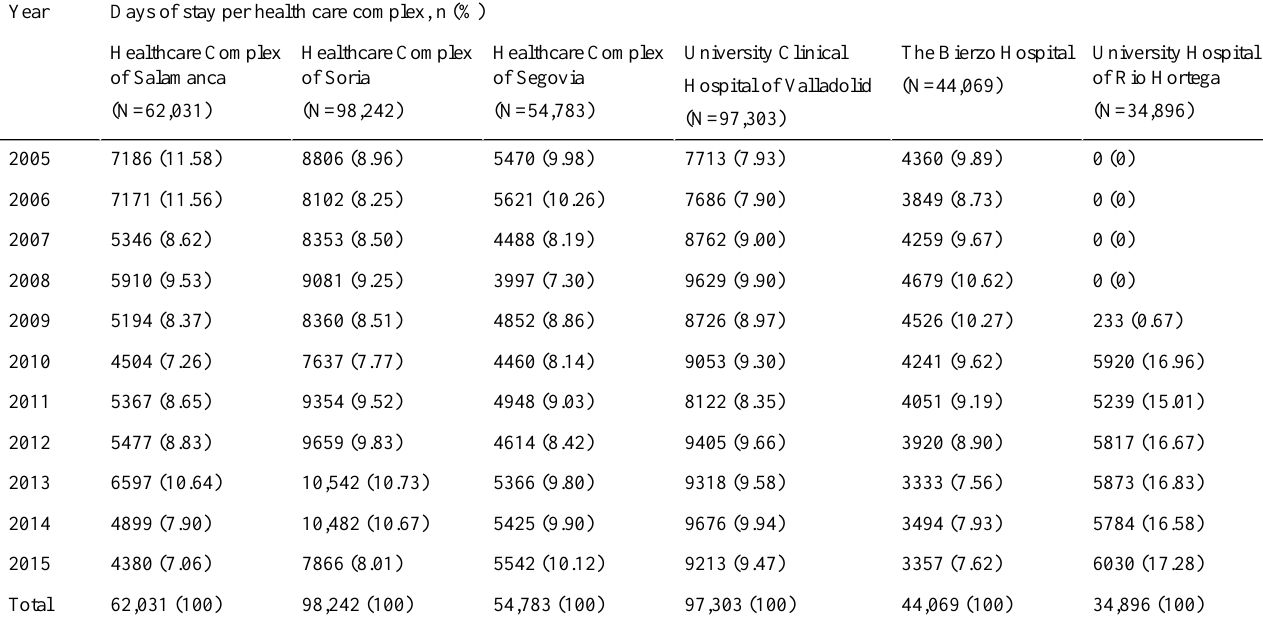
Table 2. Total number of days of stay per admission year for hospital centers in Salamanca, Soria, Segovia, Valladolid, and El